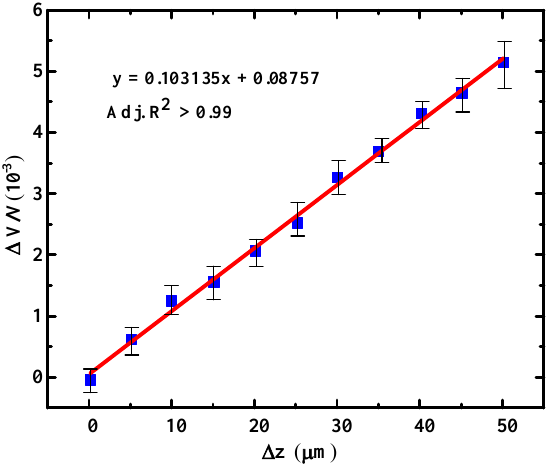
Figure 6. The relationship between the vertical displacement change Δ z of the free end of the microcantilever and the relative voltage change Δ V/V .